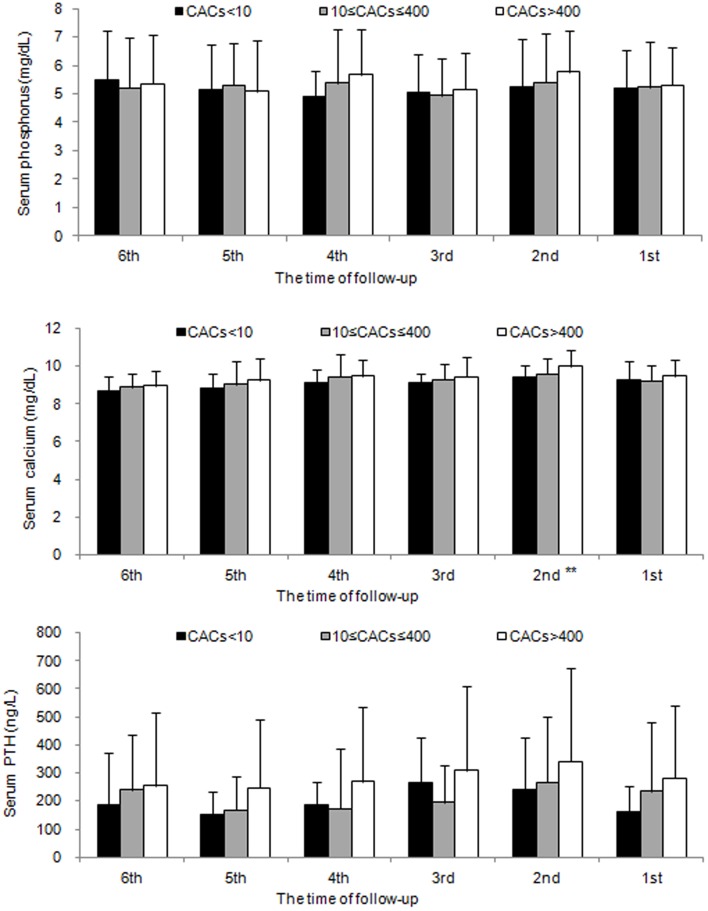
Effect of serum levels of phosphorus (top), calcium (middle), and parathyroid hormone (PTH, bottom) on CAC score during the past 6 follow-ups.The only significant differences were in the 2nd measurement for serum calcium (**
P<0.05). Each column represents mean±SD. 1st : the value at the entry of study (July, 2010); 2nd: the value of April, 2010; 3rd : the value of January, 2010; 4th : the value of October 2009; 5th : the value of July 2009; 6th : the value of April 2009.